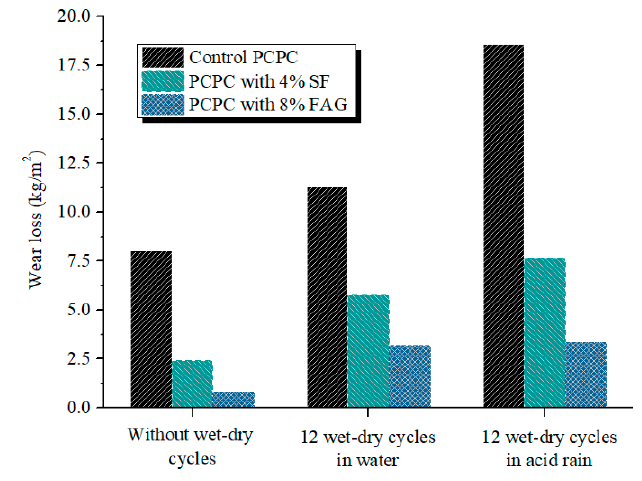
Figure 7. Wear loss of PCPC after the abrasion test.